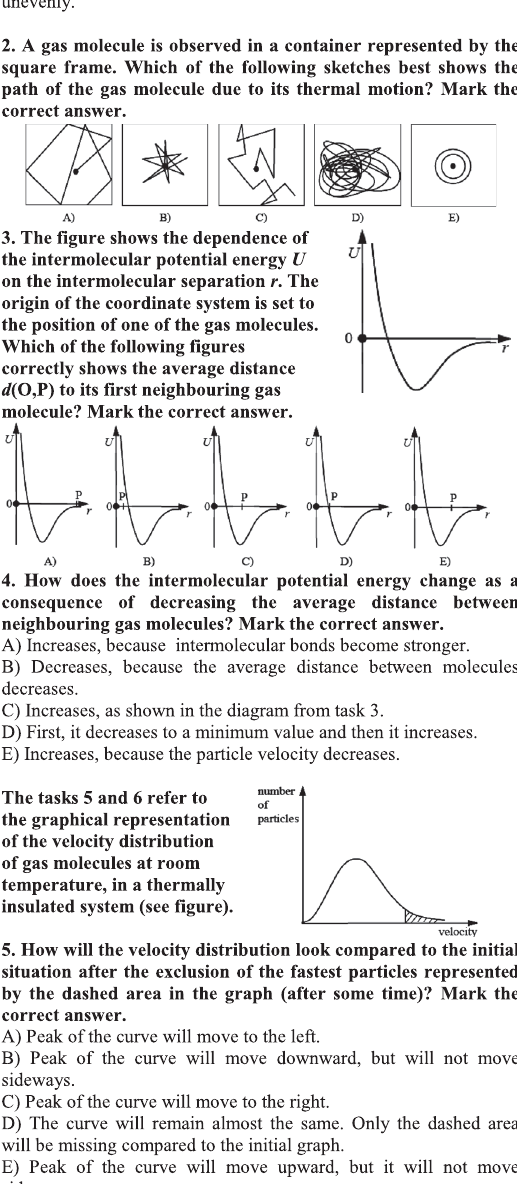
FIG. 10. First page of the kinetic molecular theory of gases concept